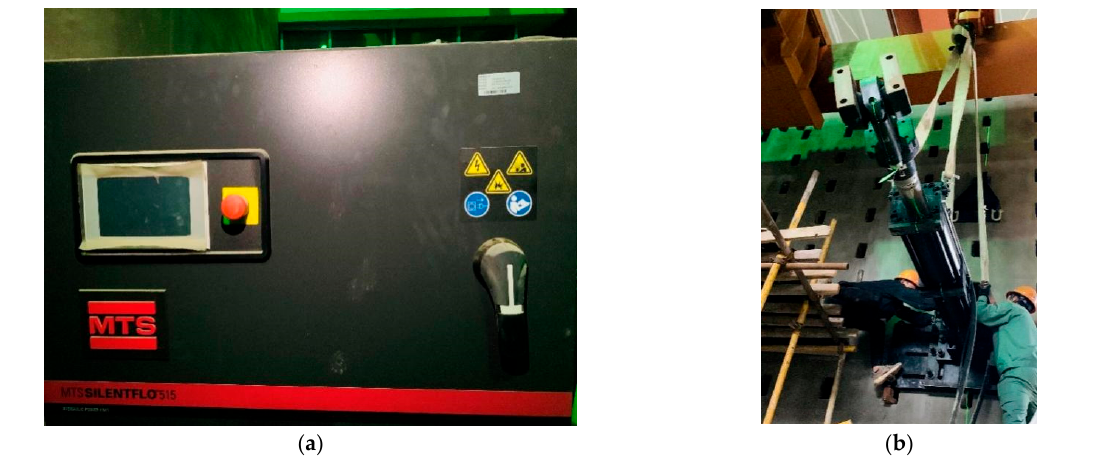
Figure 5. Photograph of the test devices: ( a ) MTS servo-loading system; ( b ) the actuator of MTS with column.